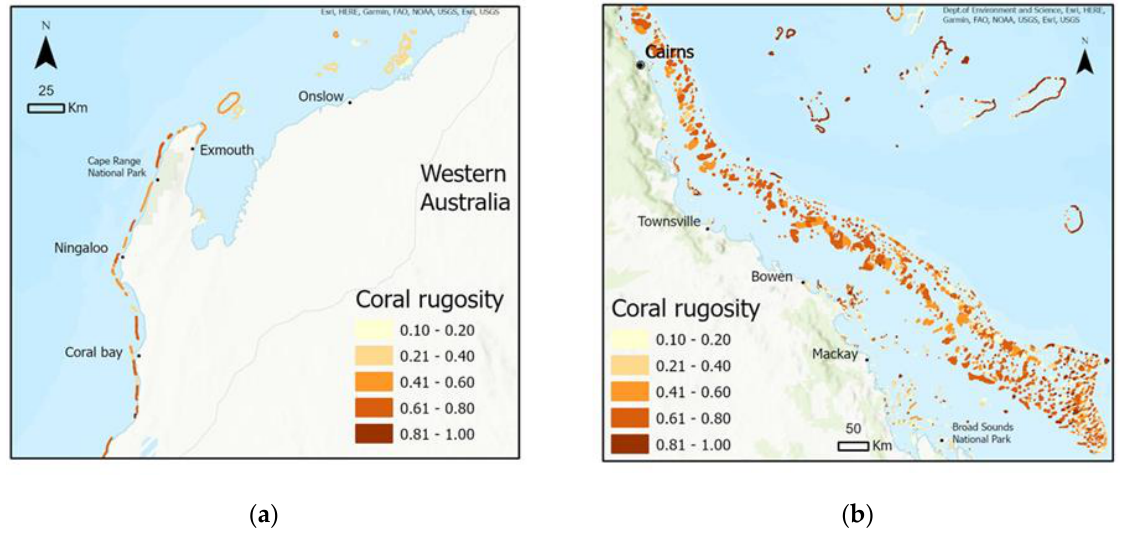
Figure 6. Exposure indicator maps of coral rugosity in the Ningaloo Reef ( a ) and the southern Great Barrier Reef ( b ). Higher (darker) values denote higher rugosity of coral reefs.